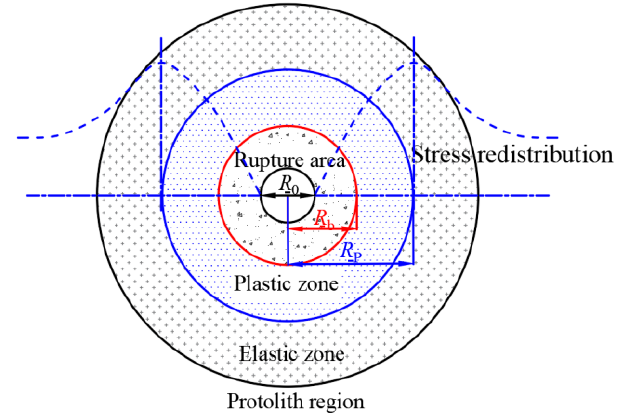
Figure 15. Partition characteristics of the borehole coal body.